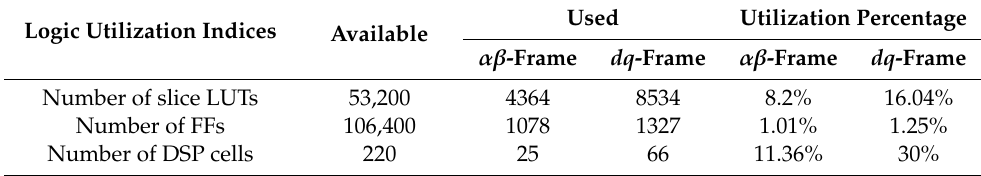
Table 5. Field-programmable gate array (FPGA) resource utilization for the FS-MPC